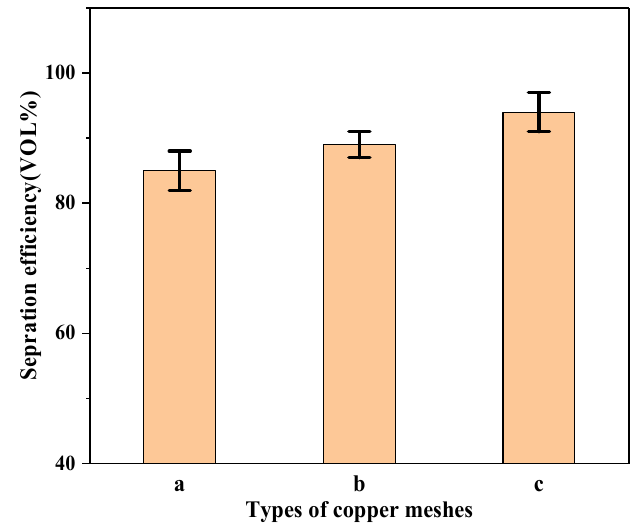
Figure 4. Results of the separation efficiency of copper meshes. ( a ) Ground with 320 grit SiC sandpaper; ( b ) ground with 800 grit SiC sandpaper; ( c ) ground with 1500 grit SiC sandpaper.